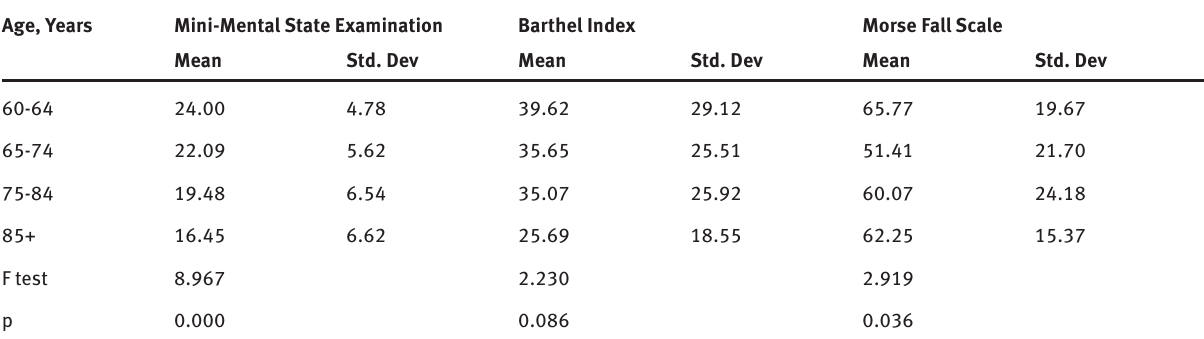
Table 3: Differences in the Mini-Mental State Examination , Barthel Index and Morse Fall Scale mean scores among the age groups